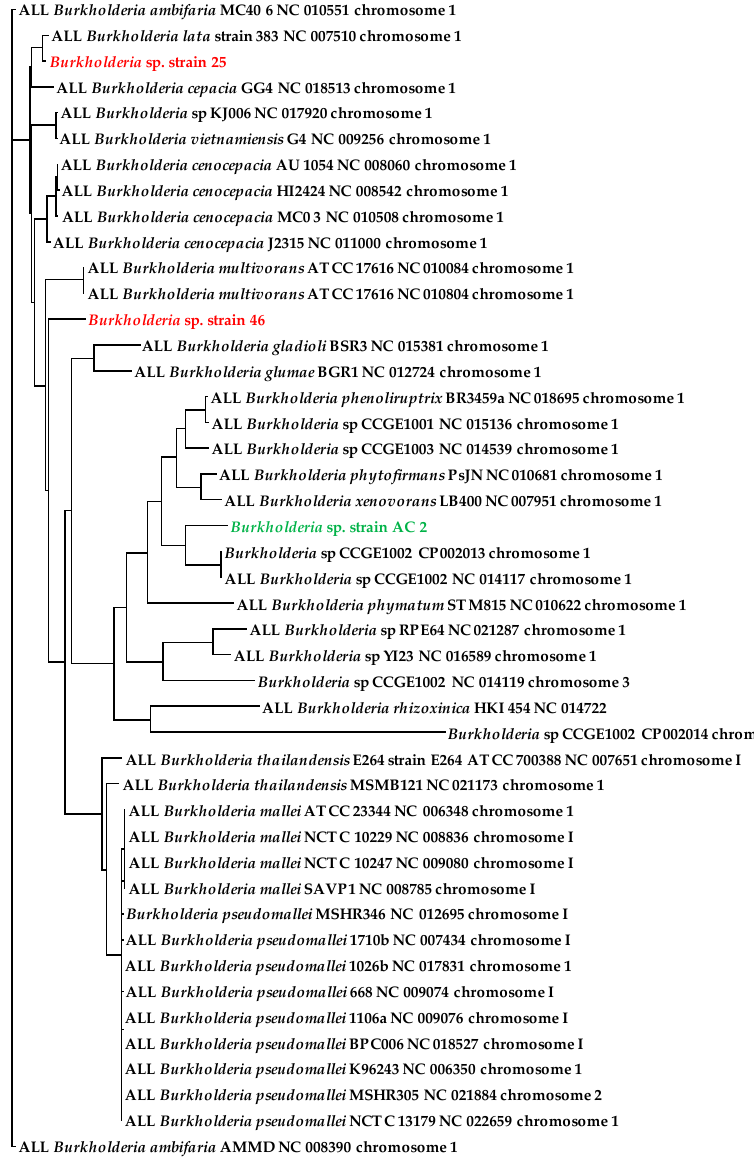
Both base composition plots were generated using a sliding window of 50,000 nt. base composition plots were generated using a sliding window of 50,000 nt.